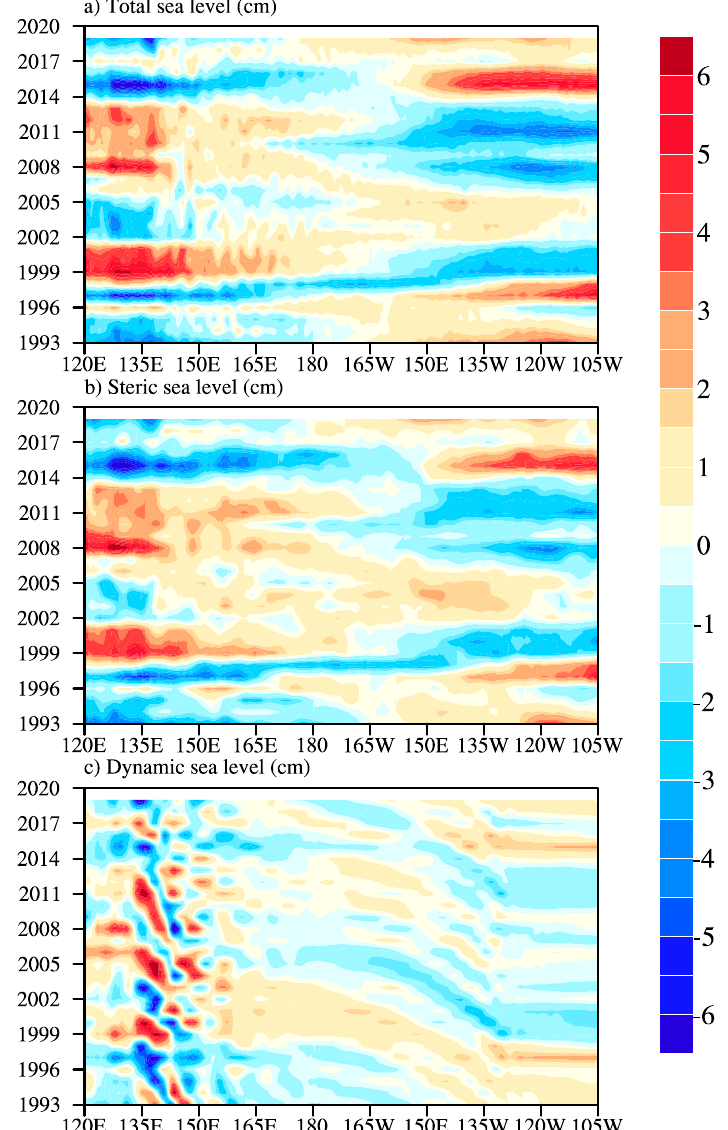
Figure 11. Time–longitude plot of the interannual to decadal sea level anomalies (cm) averaged along the 20° S–20° N latitudinal band from ( a ) altimetric observation, ( b ) steric effect, and ( c ) the 1.5-layer model.